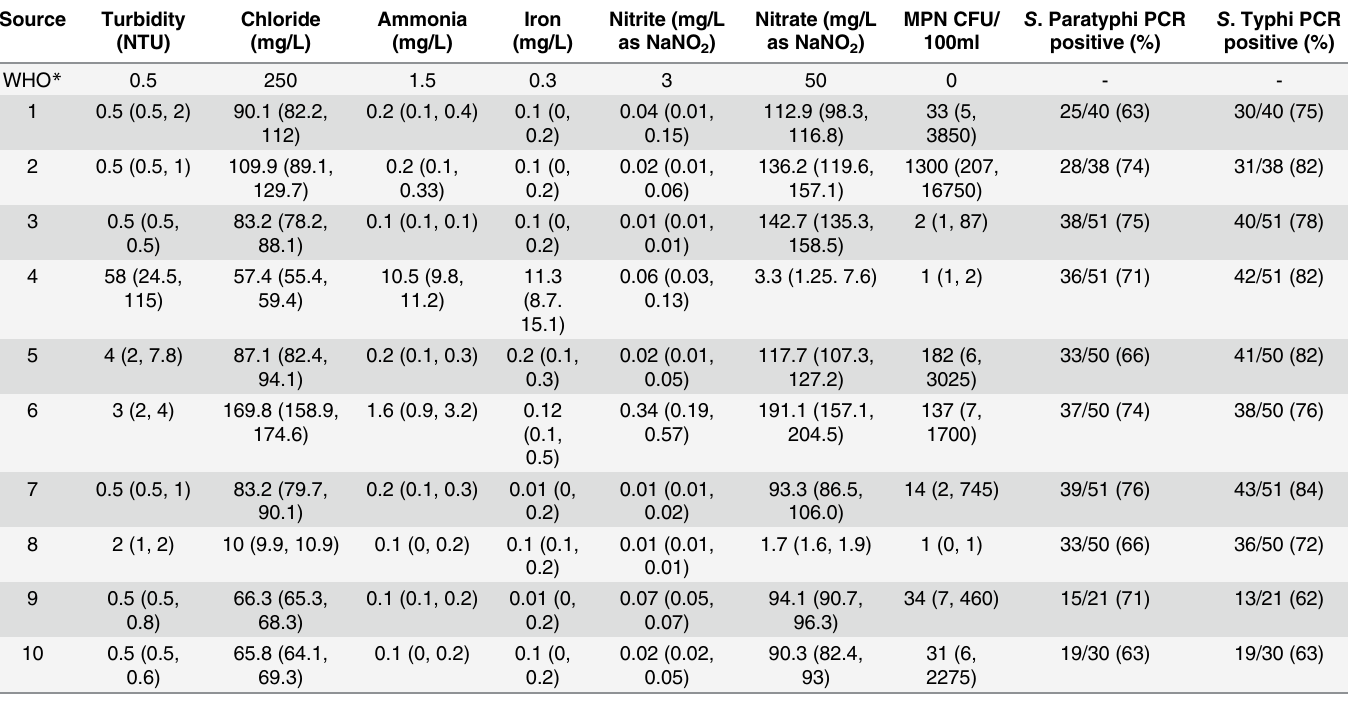
Table 2. Summary of the chemical and bacterial contamination of the water sampling